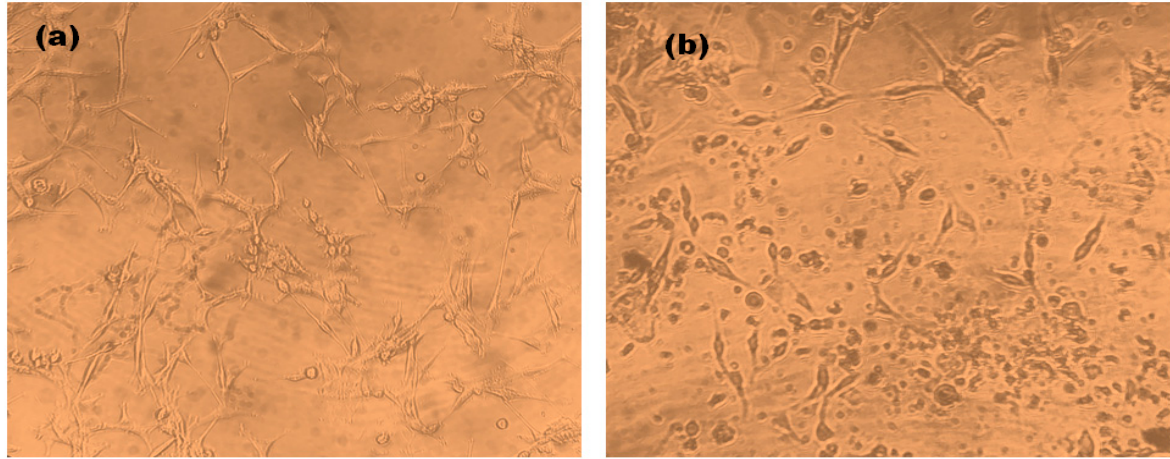
Figure 11. Cellular Morphology of U87-MG cells. ( a ) Untreated control, ( b ) Diospyros malabarica extract mediated green synthesized AgNPs treated at the IC 50 concentration.